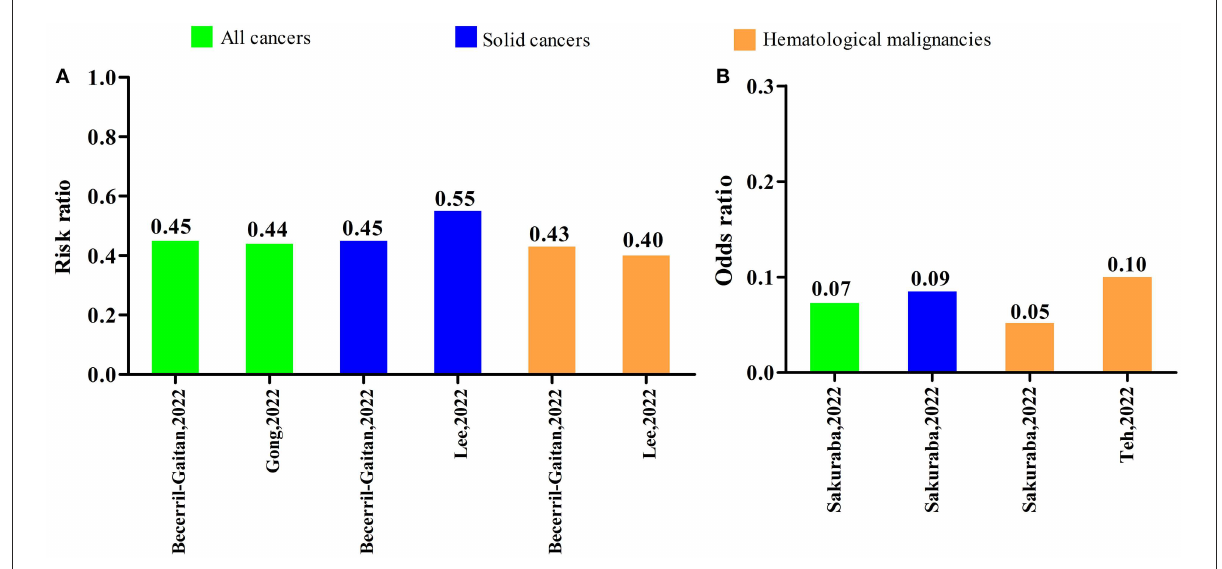
FIGURE5 Serologic response after the first dose of COVID-19 vaccine compared to controls. (A) Risk ratio (B) Odds ratio.